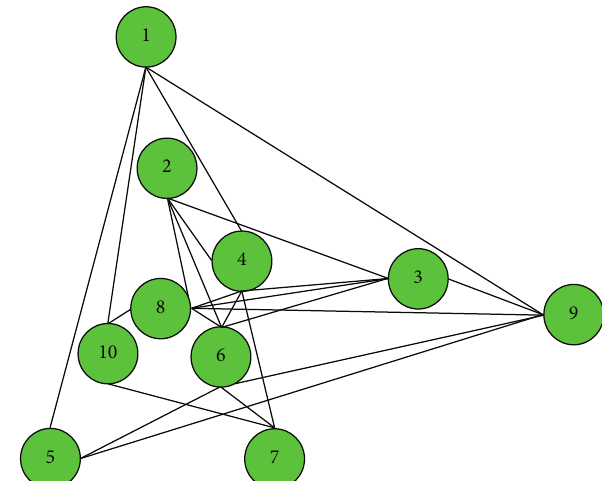
Figure 1: A simple complex dynamical network systems with ten